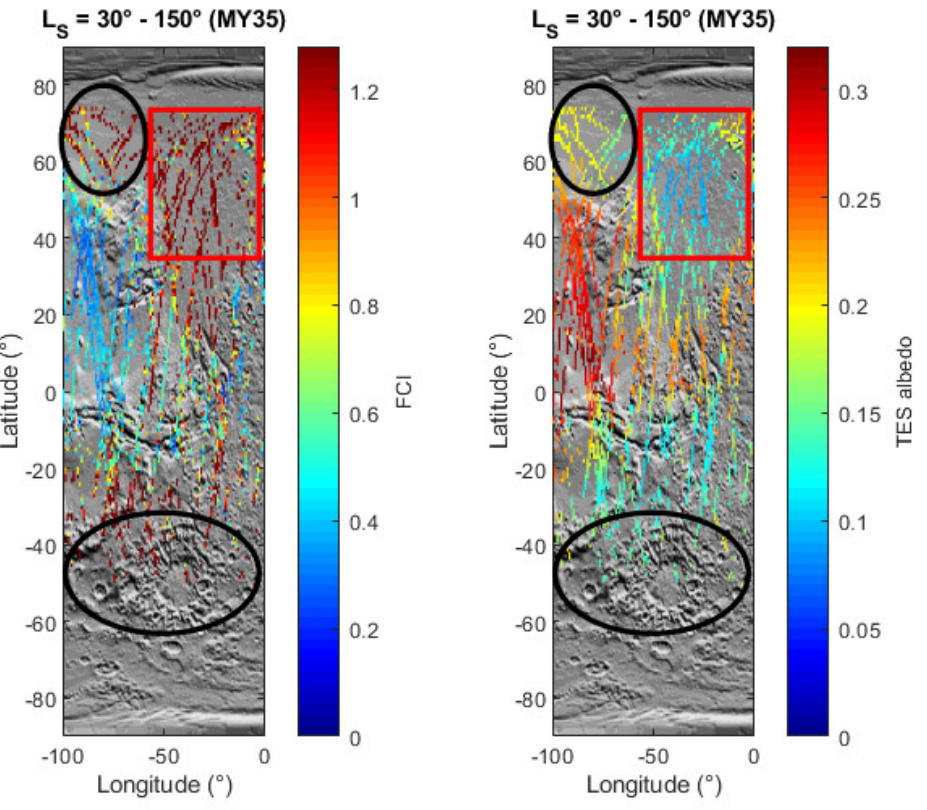
Figure 8. Left panel: LNO observations in MY35, from L S = 30 ◦ to 150 ◦ . Colour points indicate the FCI values saturated at 3.5 σ (see Section 4.1). Right panel: TES albedo values falling in each bin of the LNO tracks in MY35, from L S = 30 ◦ to 150 ◦ . Red rectangle: correlation between high FCI values and the region of low surface albedo. Black circle: example of high FCI values not correlated with regions of low surface albedo.